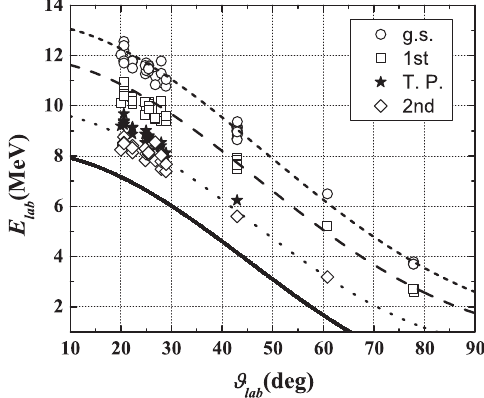
FIG. 22. Proton laboratory energy spectrum measured at 20.6° with respect to the beam. FIG. 23. Comparison between the measured energy peak at different laboratory angles and the values (solid lines) expected from two-body kinematics and different excited states of 8 Li.